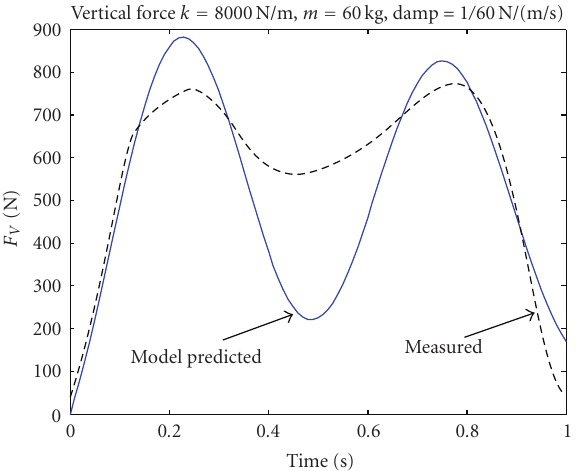
Figure 4: Ground reaction force (vertical component) obtained using the mass-spring inverted pendulum model (including a damper) compared to the real ground reaction force occurring during a single leg stance phase, measured using force plates [13].